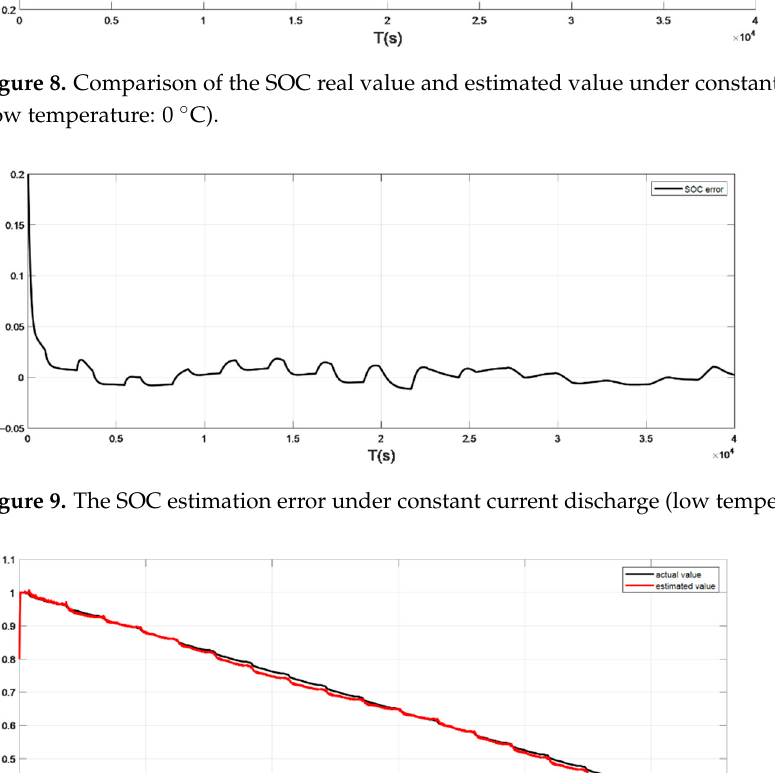
Figure 11. The SOC estimation error under UDDS (low temperature: 0 °C).